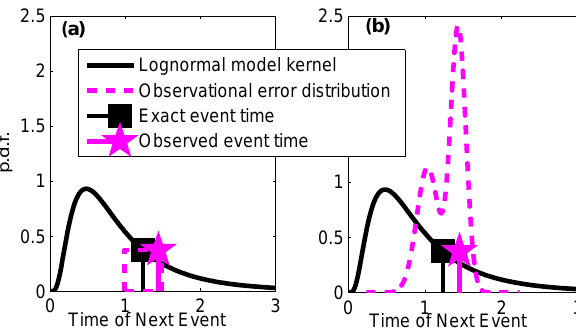
Fig. 1. Visual comparison of the model transition kernel of the (un- observable) true occurrence times (solid black curves) and the con- ditional likelihood functions of the noisy observed occurrence time given the true occurrence time (dashed magenta line). (a) Uniform error distribution. (b) Gaussian mixture error distribution. Also shown are a sample true occurrence time (black square) and a sam- ple observation (magenta